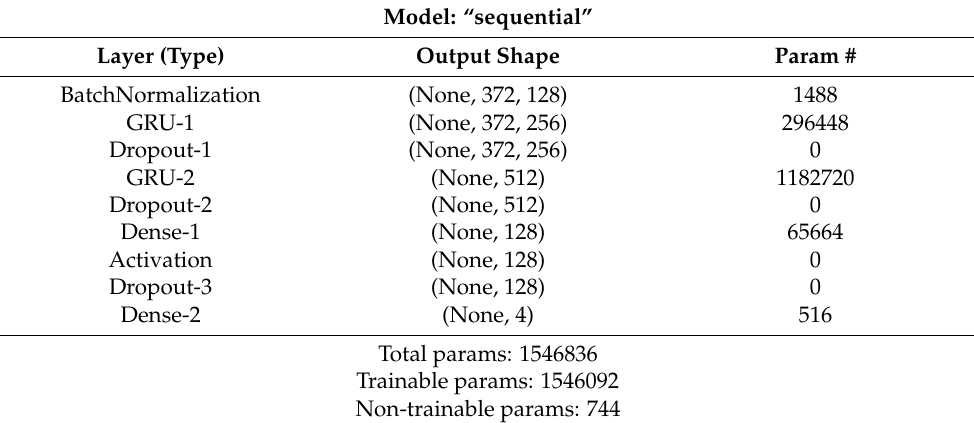
Table 3. Configuration of the GRU model with 128